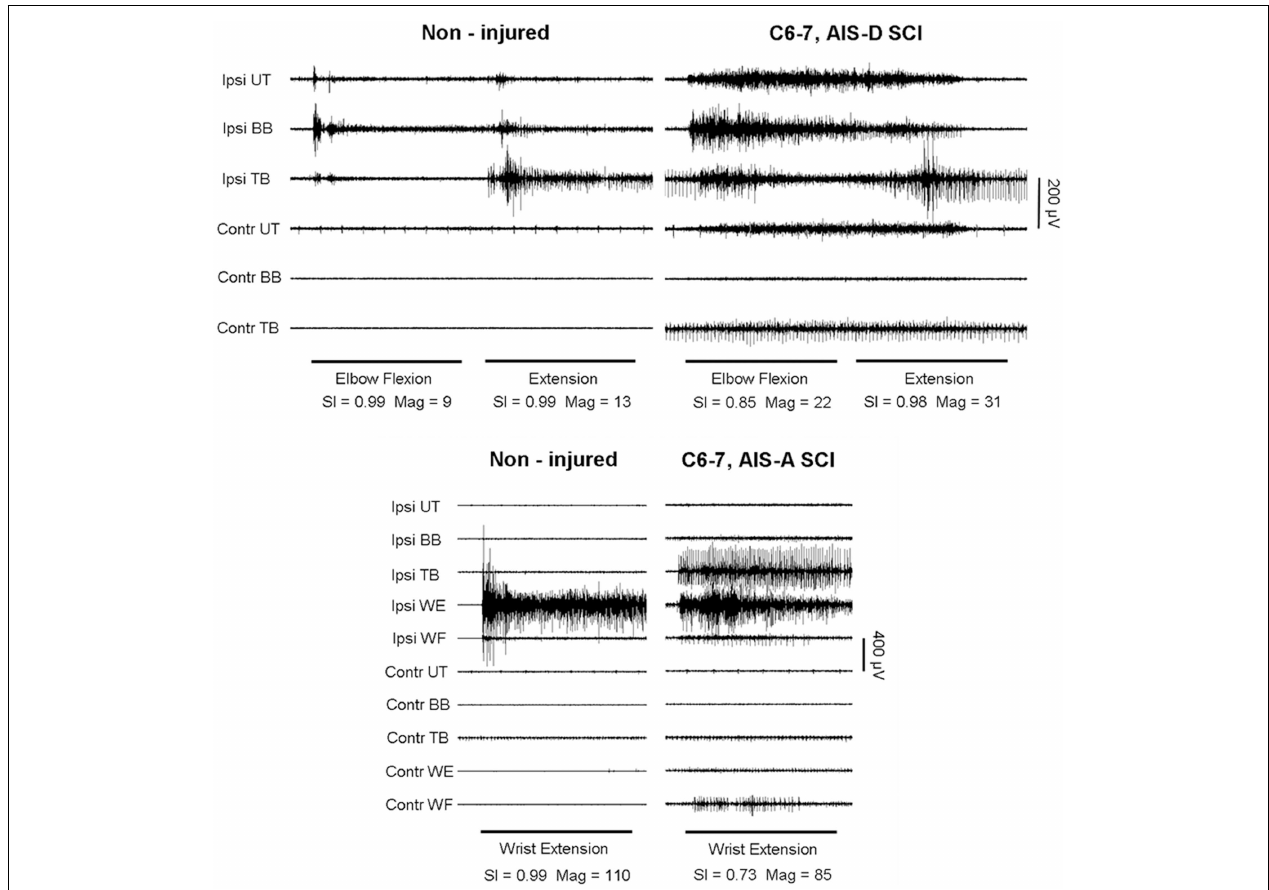
surface EMG produced magnitude (Mag) and similarity index (SI) values shown for each task. Horizontal bars denote the 5-s cuing tone and analysis window. Note the presence of antagonist muscle contractions and the greater degree of ipsilateral and contralateral muscle co-activation in the SCI subject patterns compared to those of the non-injured